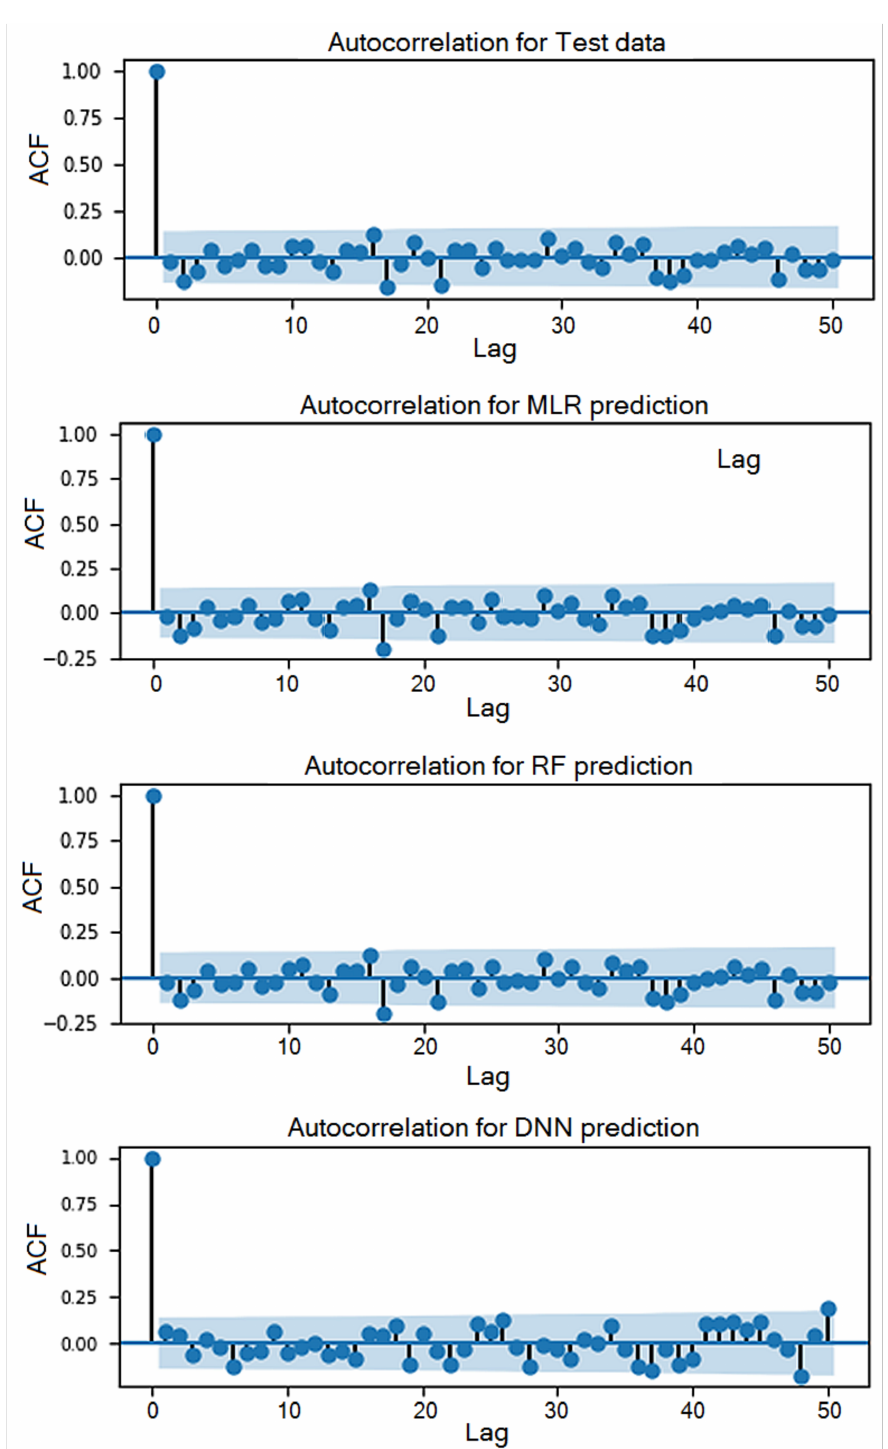
Figure 13. Autocorrelation comparison for test data and MLR, RF, and DNN prediction